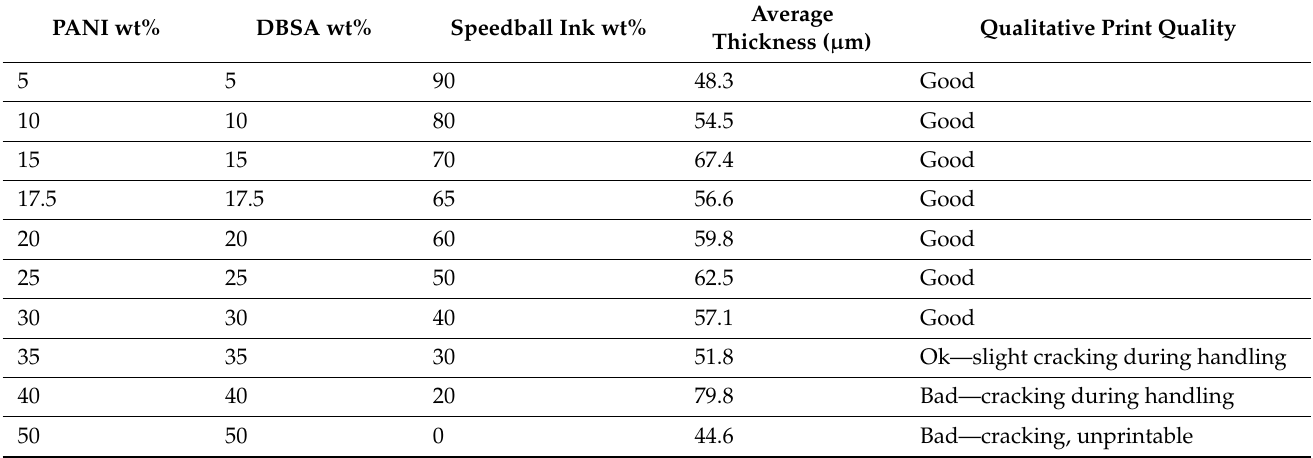
Table 1. Summary of formulations and resulting thicknesses for PANI-EB + DBSA + Speedball